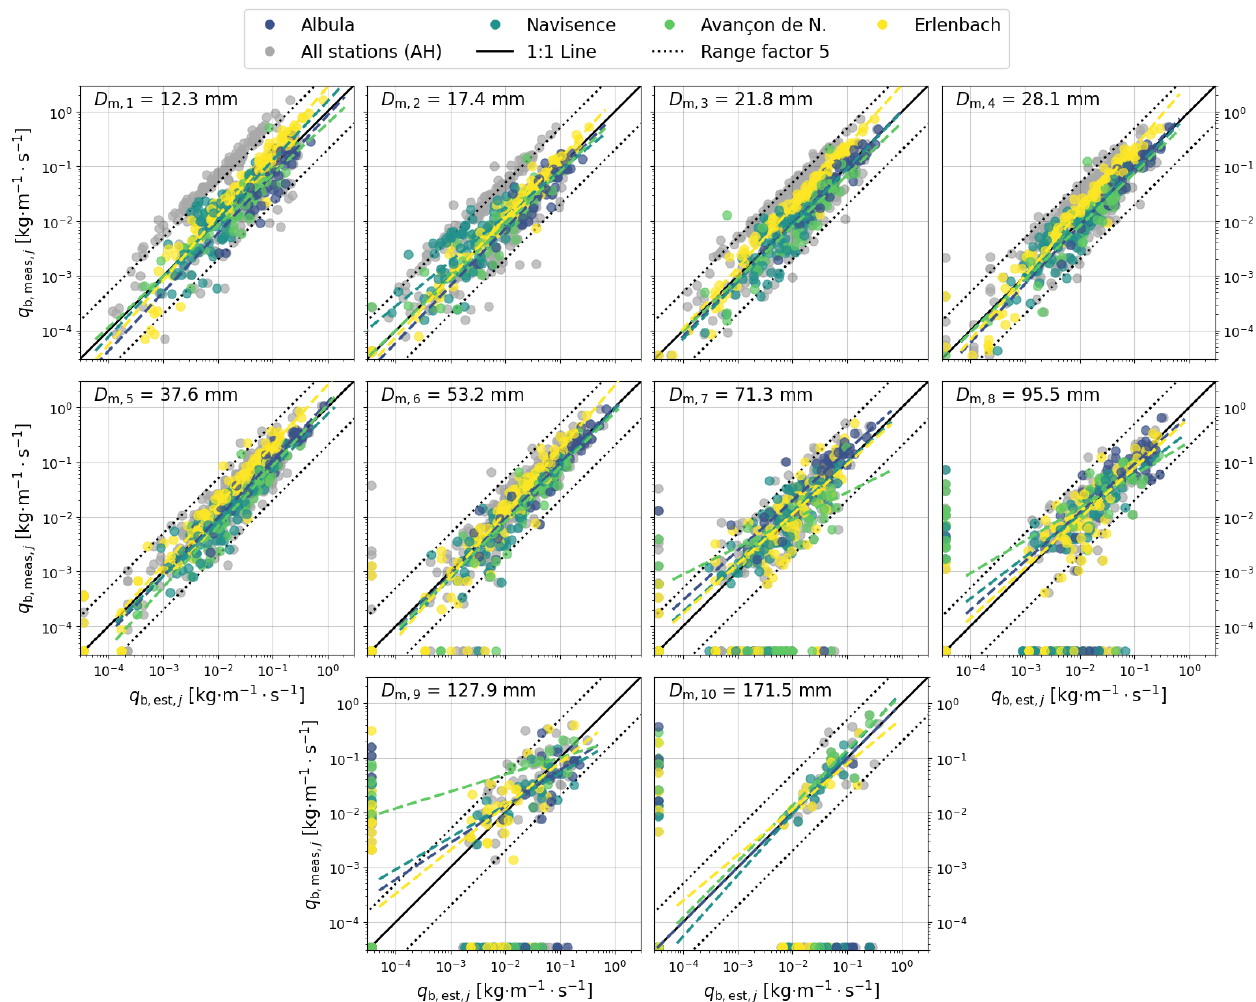
Figure 9. Unit fractional transport rate estimates obtained with the AF method for each size class j and each station. The light grey dots in the background indicate the estimates obtained with the AH method and are represented in more detail in the Supplement (Fig. S1). Each panel is annotated with the mean particle size D m ,j of the represented class. The solid black lines correspond to the reference 1 : 1 line, while the dotted lines delimit factors of 5 above and below it (from 0.2 to 5). The dashed colored lines are power-law regression lines; the mean coefficients over all four sites are listed in Table 5. The dots along the axes indicate samples for which either the measured or estimated unit fractional flux equals 0. These samples are not considered for the computation of the trend